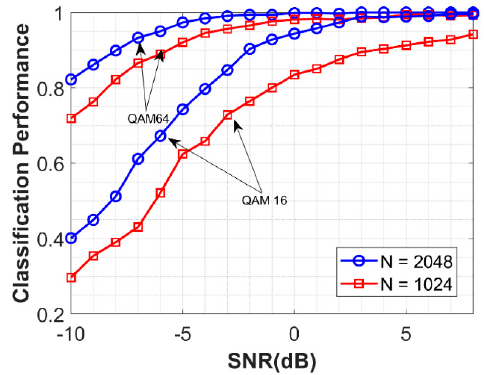
Figure 9. Performance of NSVM for QAM16 and QAM64 with N = 1024, 2048 sampling points.